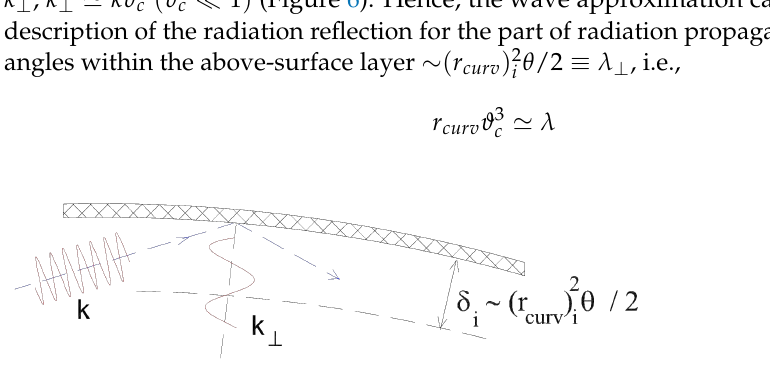
Figure 6. Illustration of the relativity for the case of grazing reflection from the curved surface. It explains the surface channeling phenomenon as a modal regime of propagation along curved surface (reproduced from [41]).